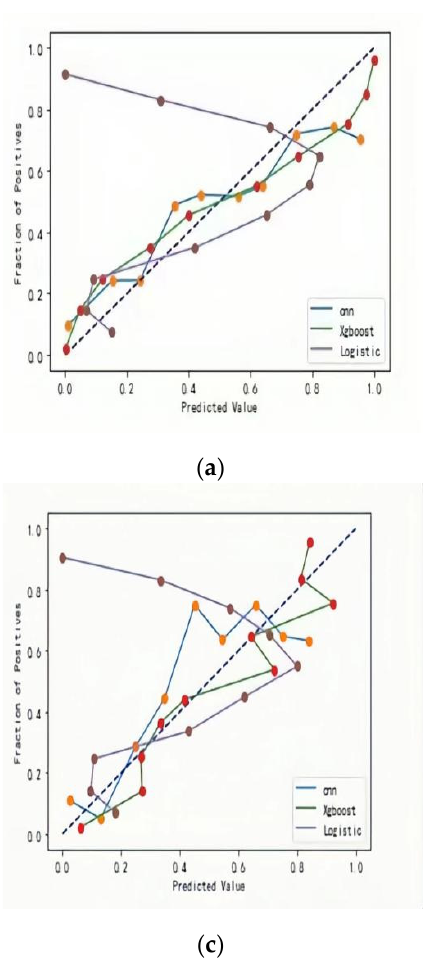
Figure 2. Calibration curves of three models ( a ) Training set; ( b ) Test set; ( c ) Validation set.